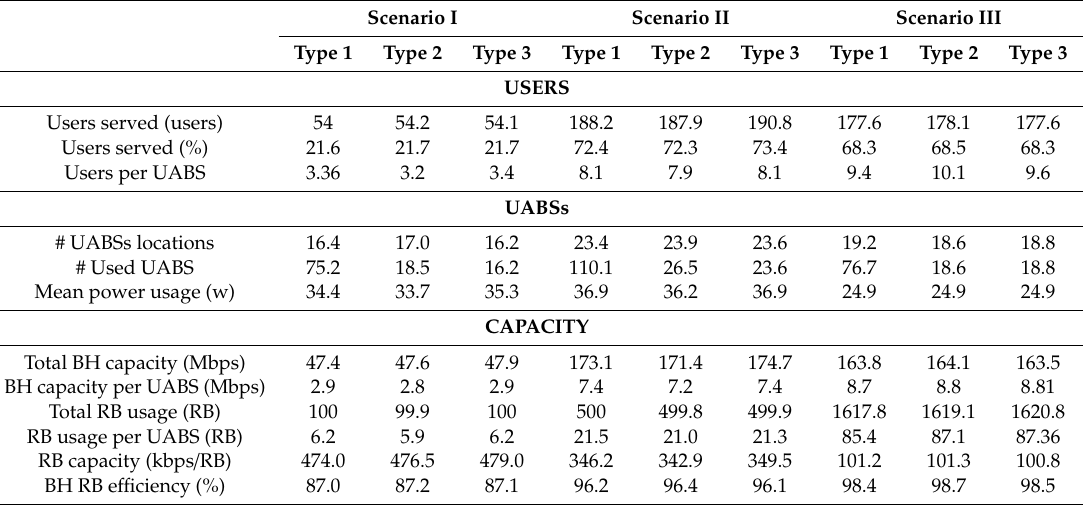
Table 4. Resume of the critical parameters for 260 users at 80 m drone